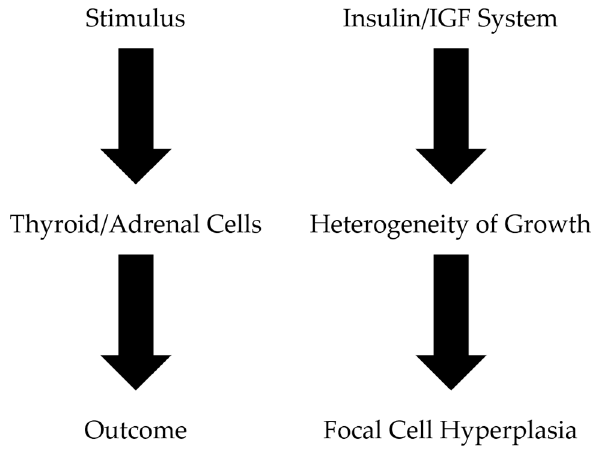
Figure 1. Pathogenesis of thyroid/adrenal nodule formation. The primary cause of the focal cell hyperplasia, characteristic of the thyroid and adrenal nodular disease, appears to be the intrinsic heterogeneity of target cells in responding to growth stimulating factors. IGF: insulin-like growth factor.